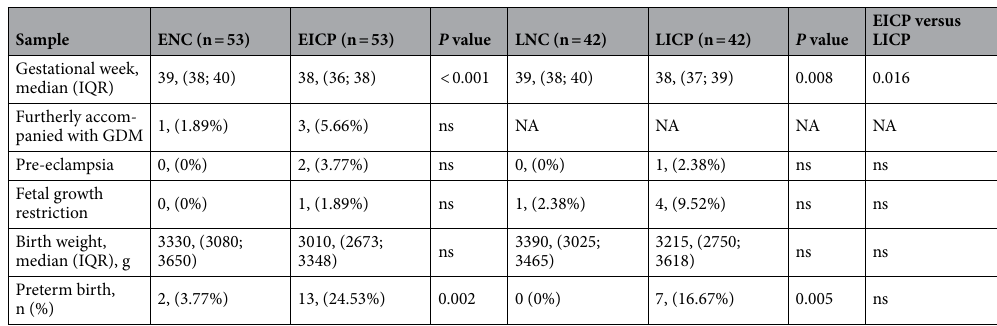
Table 3. Clinical outcomes of early and late onset ICP compared with normal pregnancy.